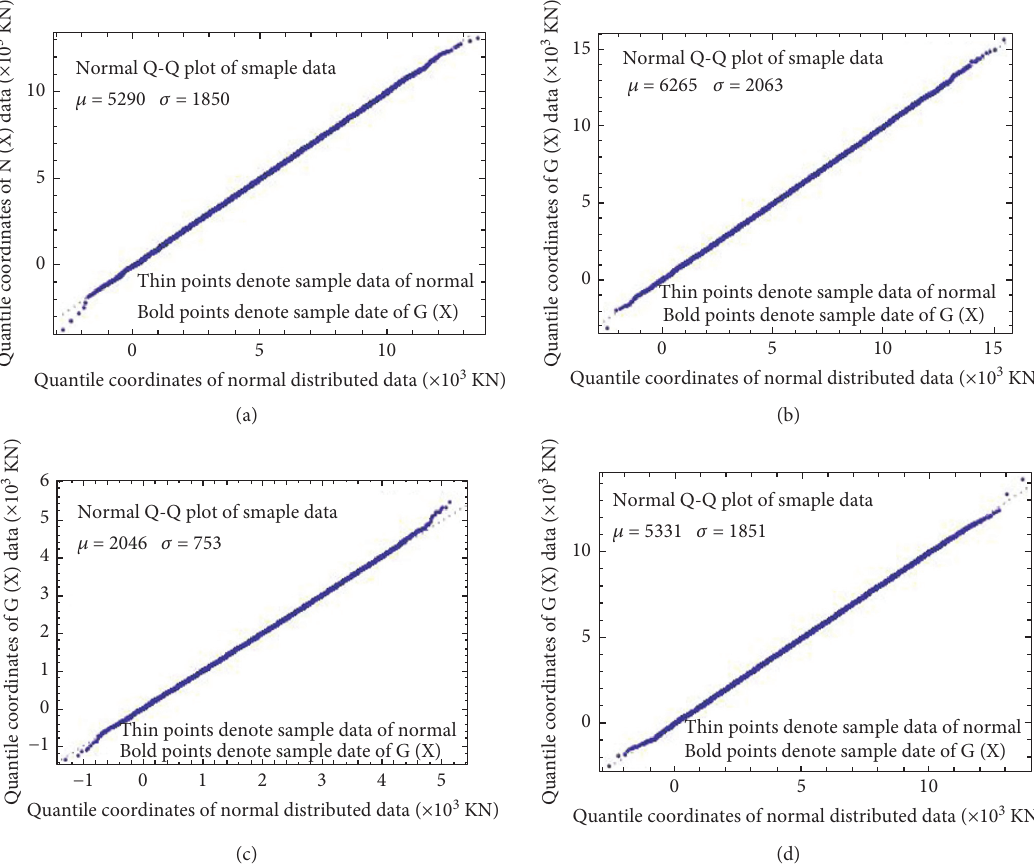
Figure 3: The normal Q - Q plot of sample data of performance function G ( X ) for each pile foundation: (a) the Q - Q plot of sample data for the no. 6 pile, (b) the Q - Q plot of sample data for the no. 6 pile, (c) the Q - Q plot of sample data for the no. 87 pile, and (d) the Q - Q plot of sample data for the no. 156